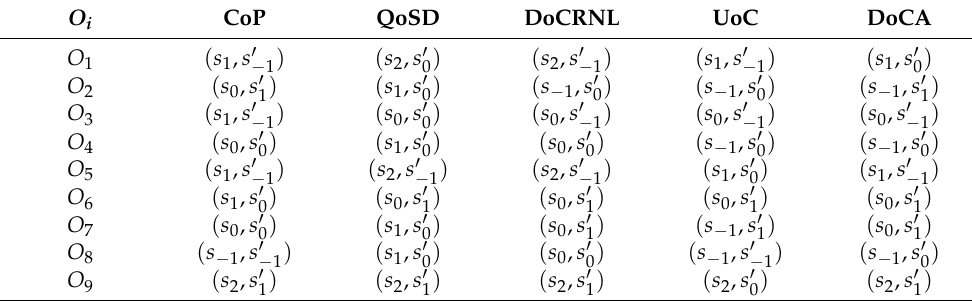
Table 6. Qualitative matrix for criteria evaluation by decision-maker 2 ( Γ 2 ).